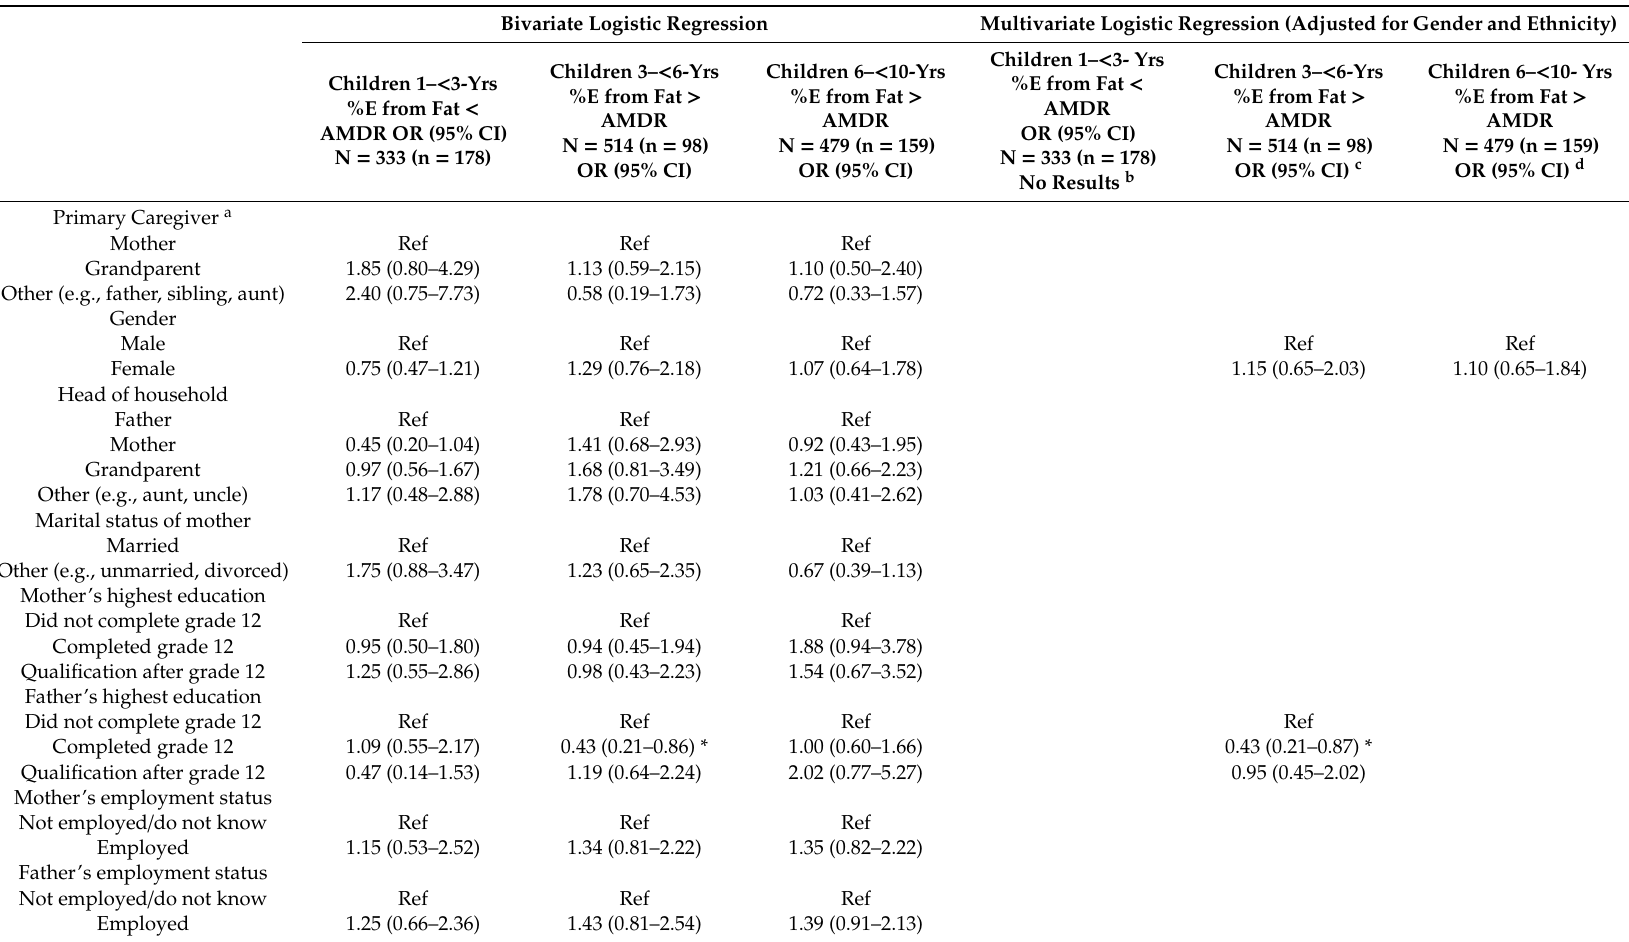
Table 9. Bivariate and multivariate logistic regression of sociodemographic factors on having a fat intake below and above the acceptable macronutrient distribution range for fat (AMDR) by age